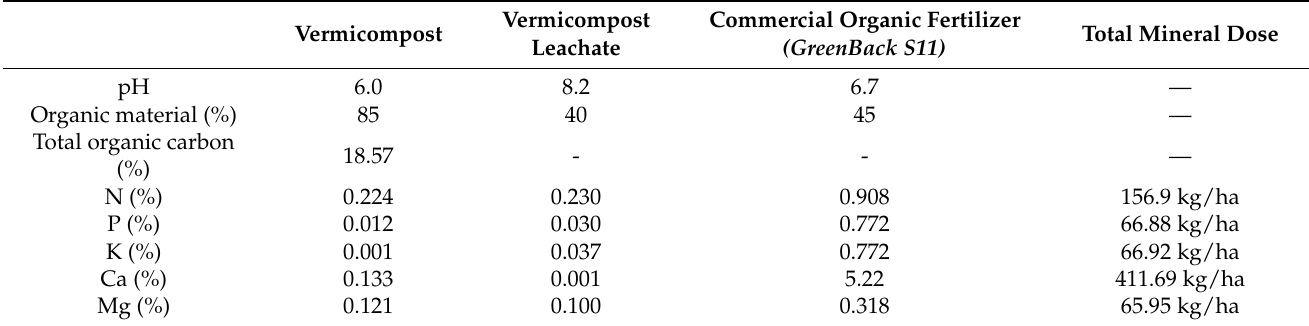
Table 1. Chemical and physical characteristics of vermicompost, vermicompost leachate, and commercial organic fertilizer, and the amount of minerals applied (kg/ha).